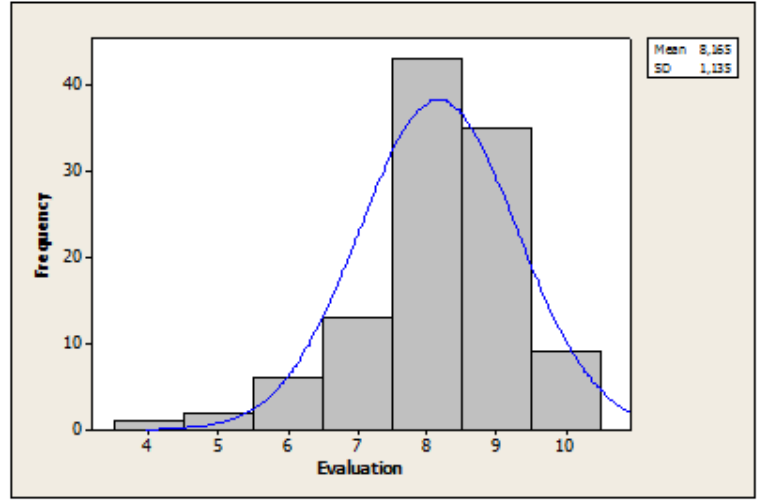
Figure 2. Assessment of the teaching quality in EXPLORE courses on a scale from 0 to 10, where 0 indicates “not at all satsfed” and 10 is “completely